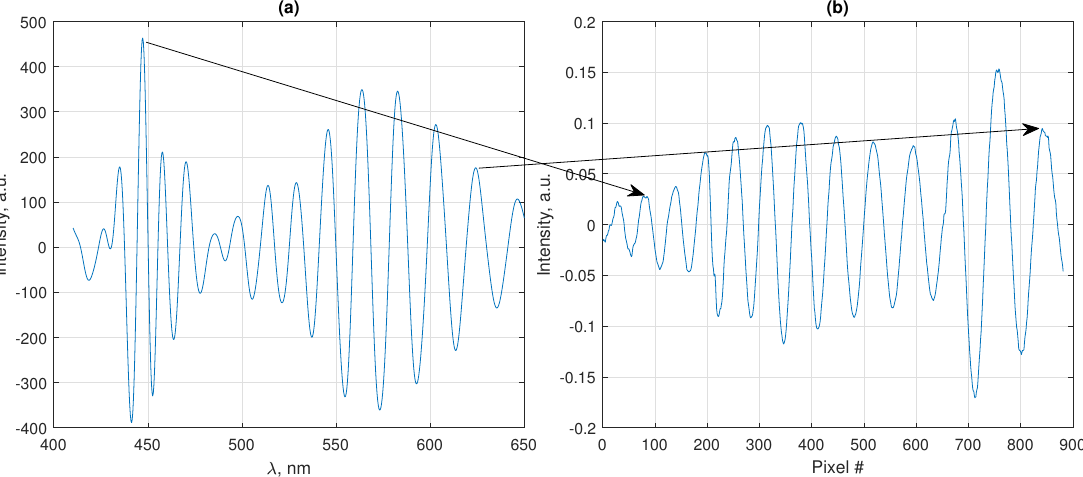
Figure 3. Comparison of stable Fabry-Perot interferometer (FPI) spectra measured with commercial spectrometer ( a ) and smartphone-based spectrometer (SPBS) ( b ). Arrows show the first and the last pairs of corresponding peaks, used for